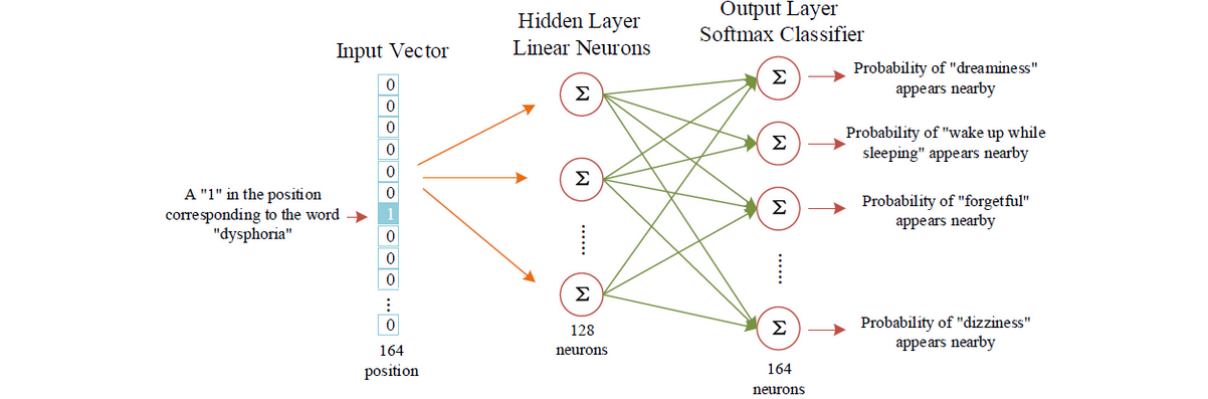
Figure 4. Skip-Gram model of